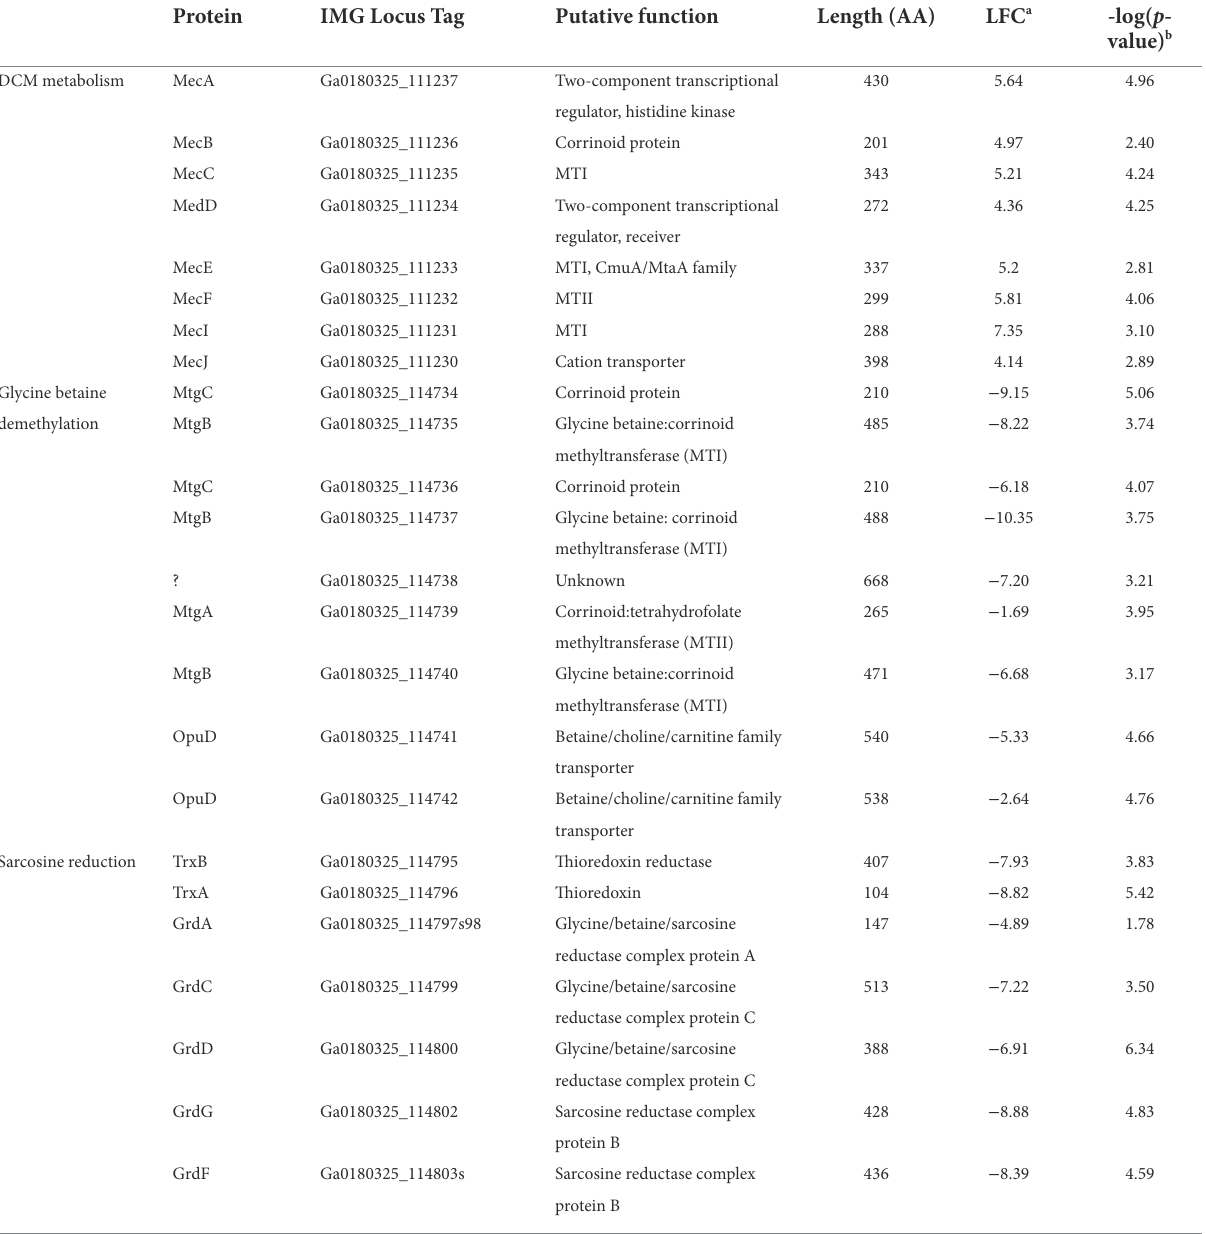
TABLE 2 List of proteins putatively involved in DCM and glycine betaine metabolism in strain DCMF. Protein IMG Locus